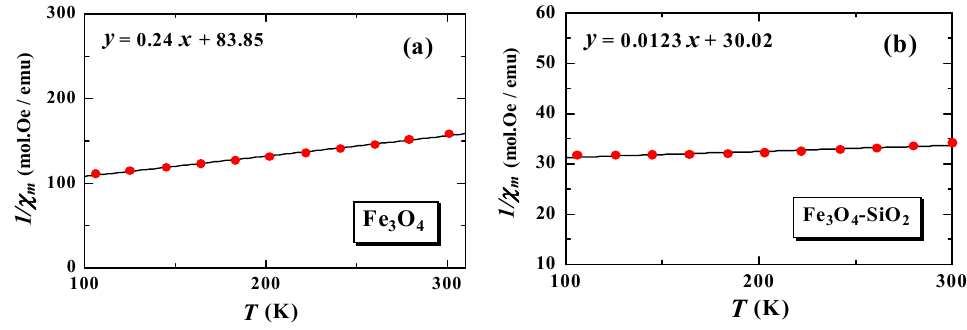
Figure 3. The first derivative curve of 𝑀 ( 𝑇 ) FC versus temperature of sample Fe 3 O 4 .